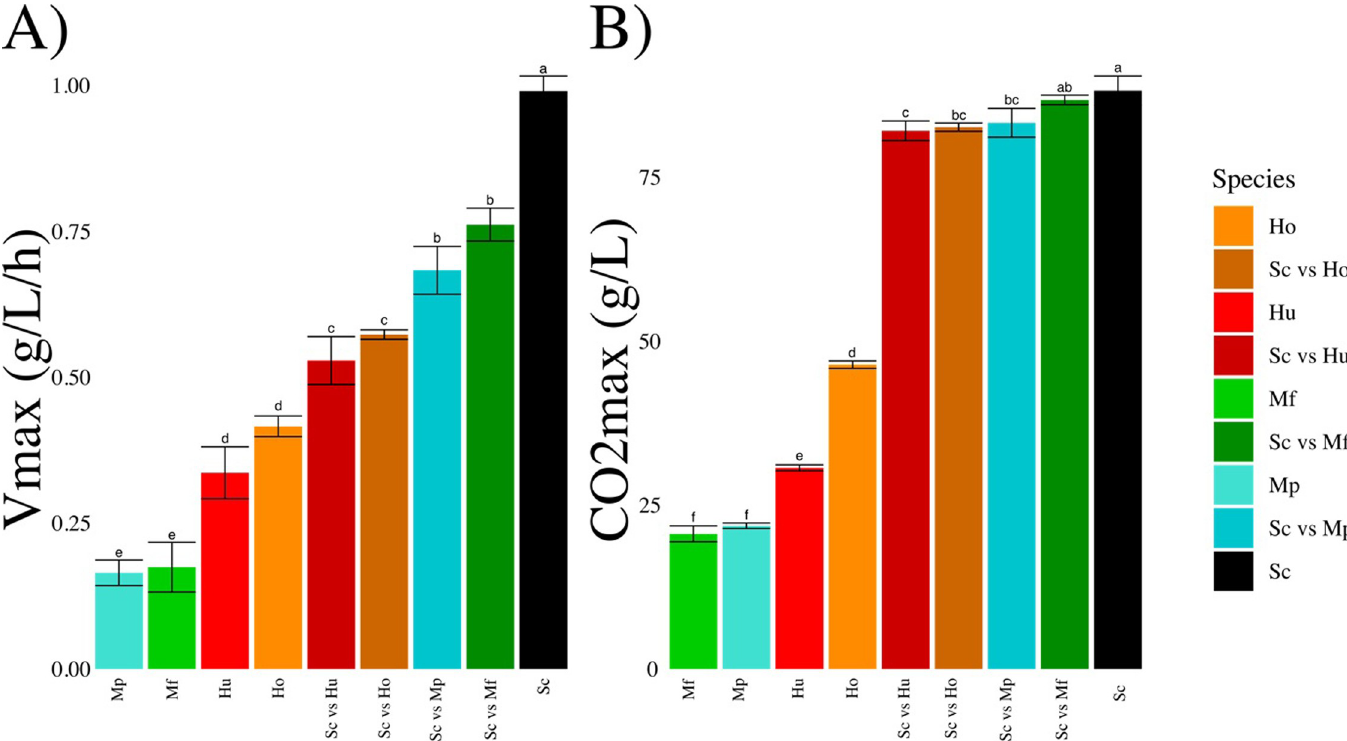
Fig 1. Maximum rate of CO 2 production, Vmax (A) and total CO 2 produced (B) in function of the single or mixed species driving each fermentation. Values correspond to average ± standard deviation. The small letters indicate the statistical groups from a Tukey analysis.